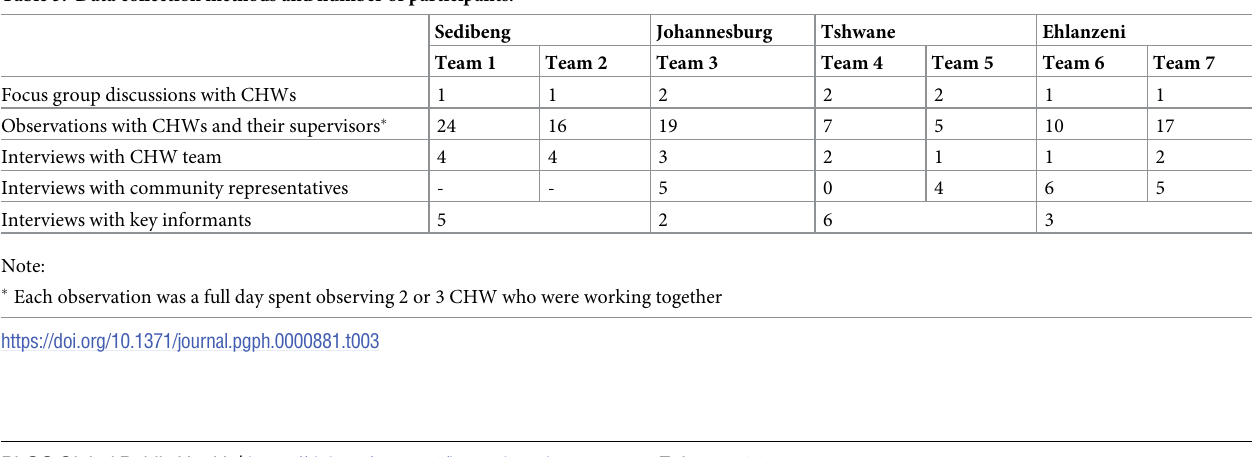
Table 3. Data collection methods and number of